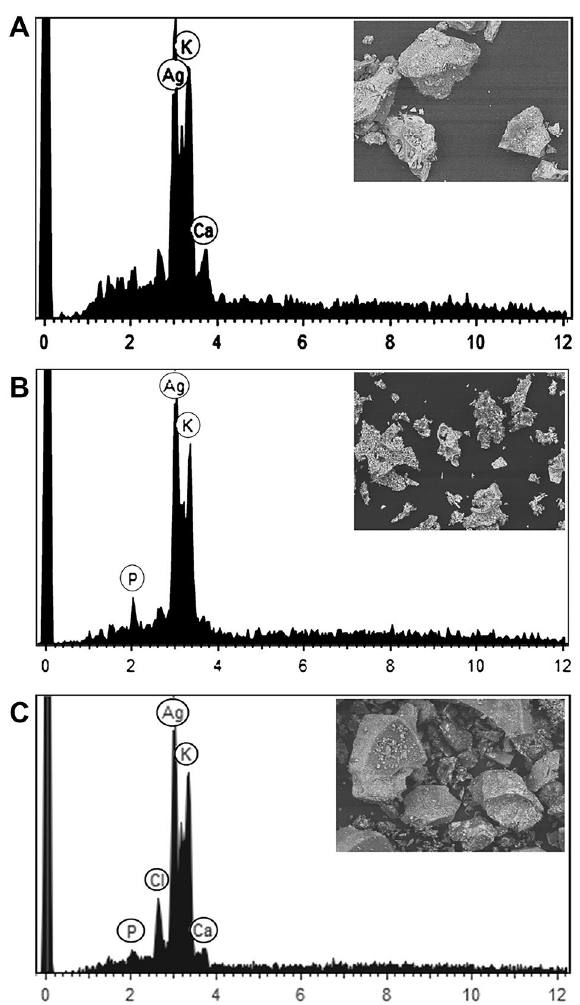
Figure 7. EDX spectra for ( A ) AgNP-F, ( B ) AgNP-S and ( C ) AgNP-W along with SEM image area